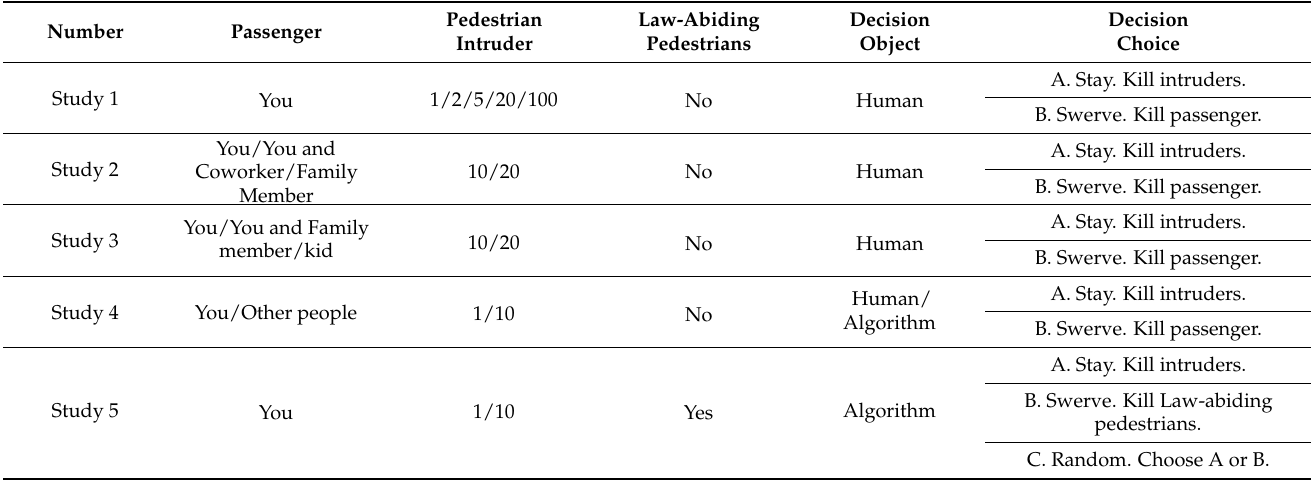
Table 2. Scene information of five